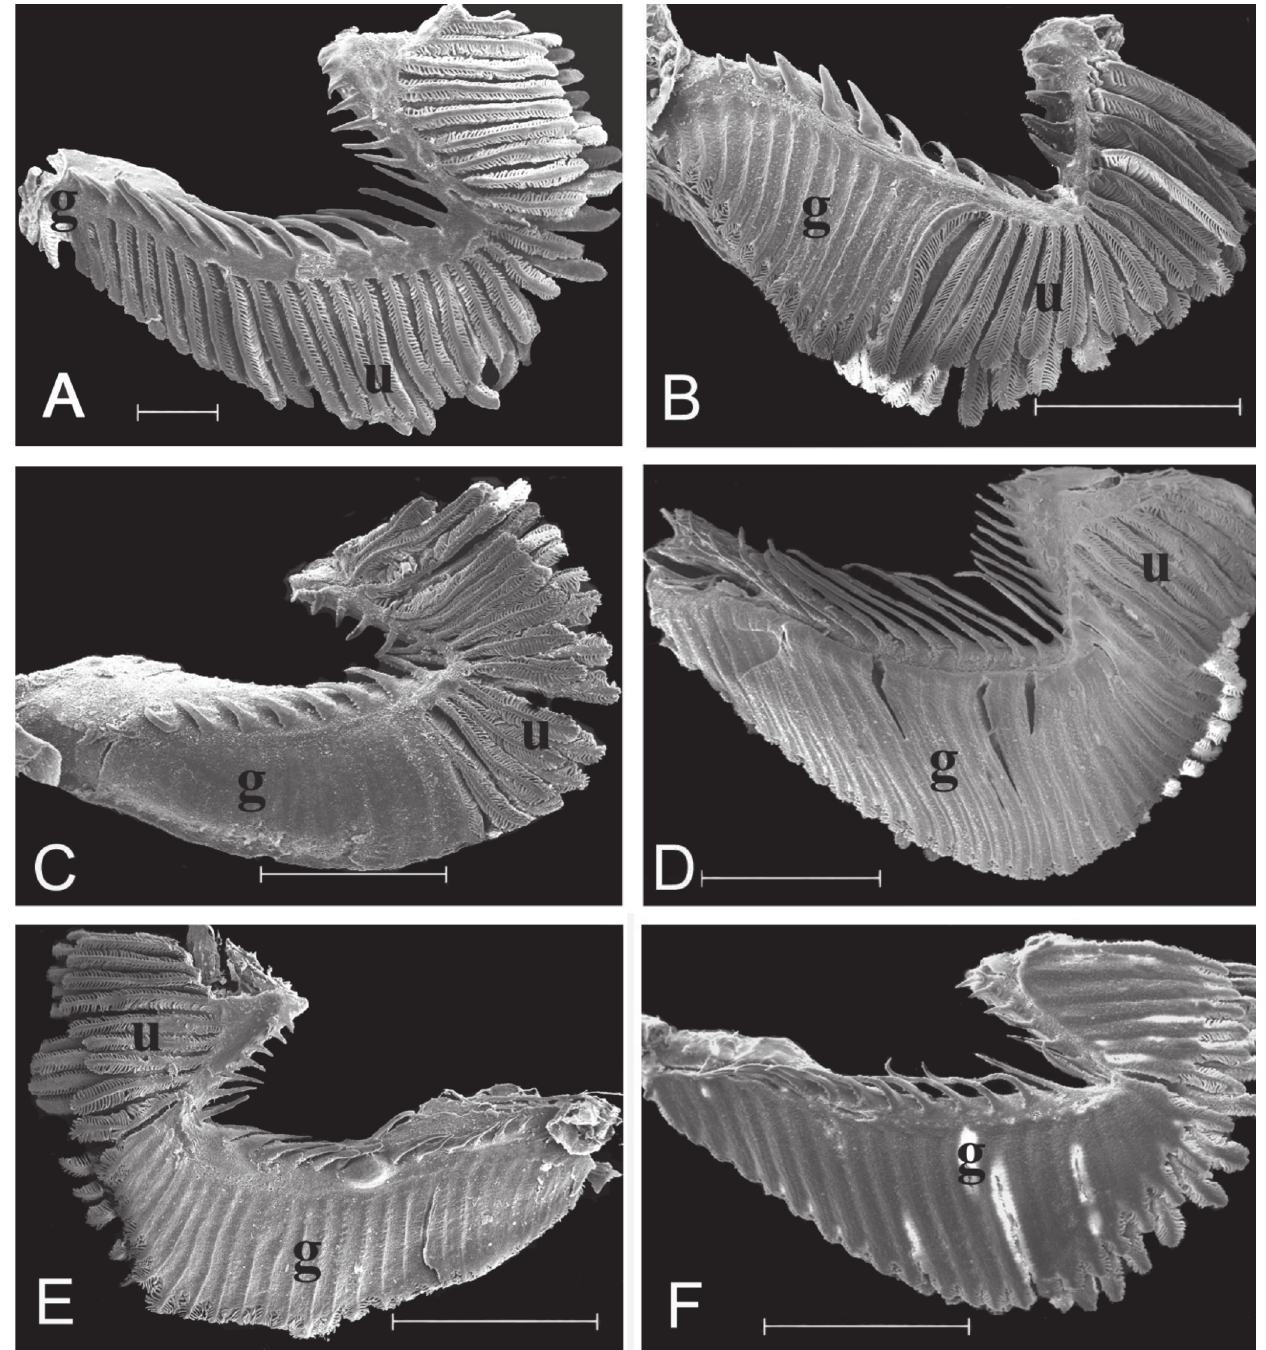
Fig. 1. Scanning electron micrographs (SEMs) of first left ( A-D, F ) and right ( E ) gill arches of male inseminating cheirodontines, ( A ) Acinocheirodon melanogramma , ( B ) Compsura heterura , ( C ) Kolpotocheirodon theloura , ( D ) Macropsobrycon uruguayanae, ( E ) Odontostilbe dialeptura , and ( F ) Saccoderma hastata . Gill glands (g), unmodified gill filaments (u). Scale bars: 1